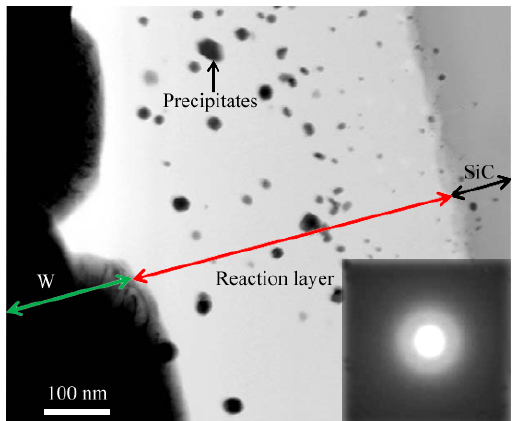
Fig. 5 Interfacial microstructure of diffusion-bonded SiC/W joint. The reaction layer is amorphous and contains Si, O, and C, and the fine precipitates contain O, Si, and W. Reproduced with permission from Ref. [28], © Elsevier B.V.